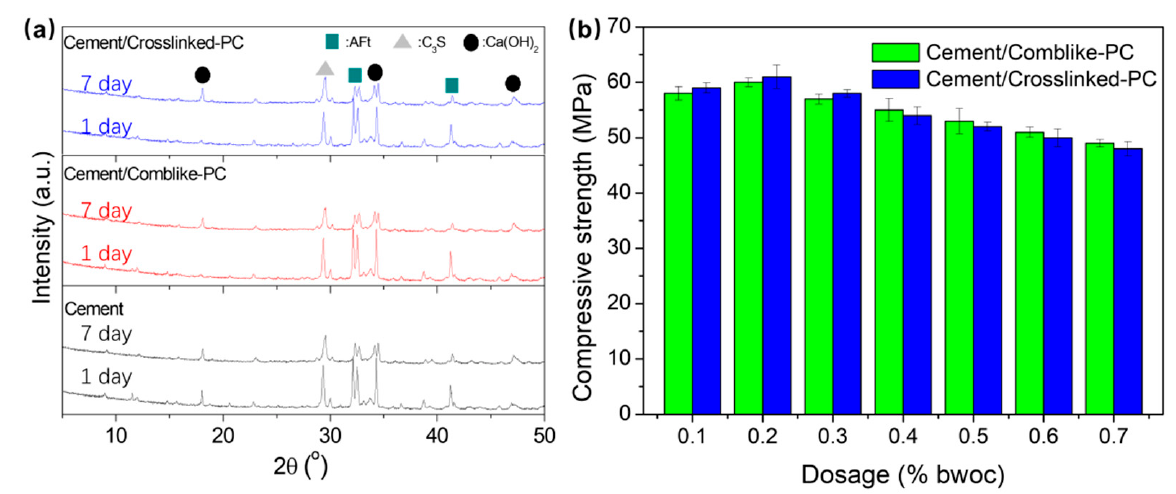
Figure 10. WAXD patterns ( a ) and the compressive strengths ( b ) of the hydration products.